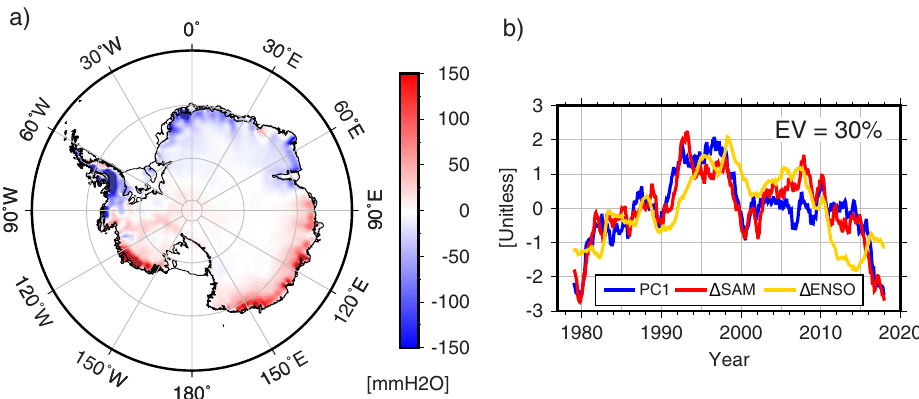
Figure 3. Spatial ( a ) and temporal ( b ) patterns of the first REOF mode calculated from the leading three EOF modes of AIS (cid:31) SMB. Red and yellow lines in ( b ) shows (cid:31) SAM and (cid:31) ENSO, respectively. For clarity, (cid:31) SAM and (cid:31) ENSO are displayed with reversed sign. Figures are created with Generic Mapping Tools (GMT-5.4.5, https ://gmt.soest .hawai